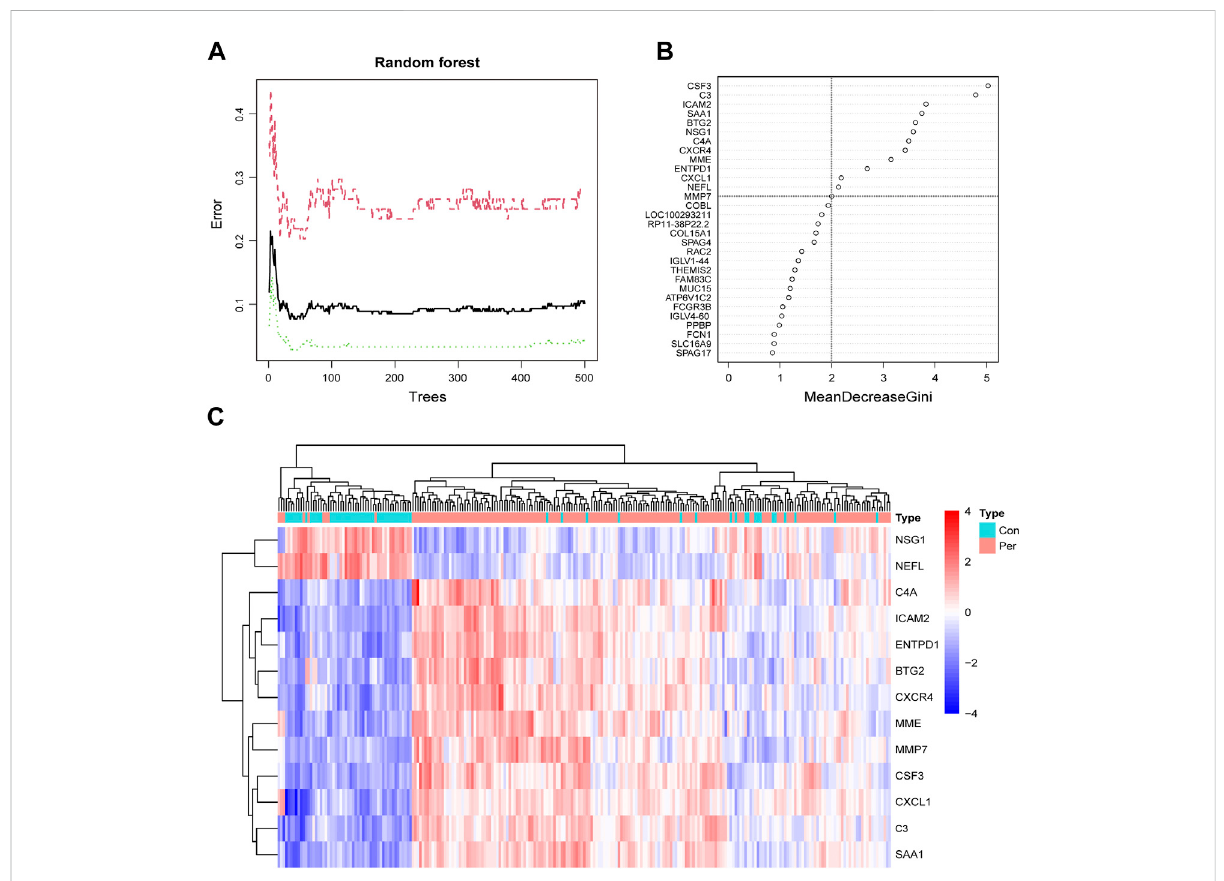
FIGURE 4 Screening periodontitis biomarkers by random forest. (A) The correlation plot between the RF trees number and error rate. The x -axis is the number of trees, and the y -axis is the error rate of cross-validation. The red curve represents the treat group, the green curve represents the control group, andtheblackcurverepresentsall samples. (B) The Ginicoef fi cientmethodinrandomforest modeling ofthetraining cohort.The importance index is on the x -axis, and the genetic variable is on the y -axis. (C) Heatmap of the 13 key periodontitis